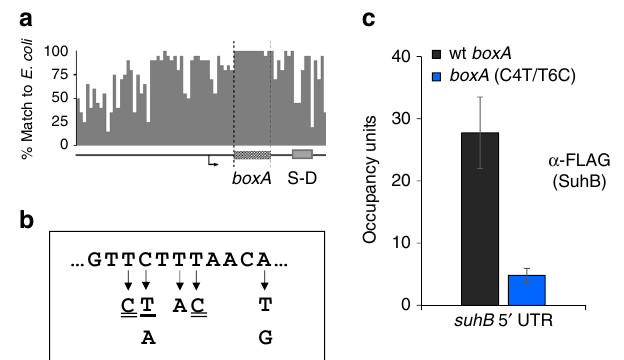
Fig. 2 A functional BoxA in the 5 ′ UTR of suhB . a Sequence conservation of the 100 bp upstream of suhB and its homologues across 20 Enterobacteriaceae species. The transcription start site is indicated by a bent arrow, and the BoxA and S-D sequences are indicated. b List of boxA mutations that are associated with increased suhB expression. All single nucleotide changes are indicated by an arrow. Single underline indicates a mutation that was isolated in the absence of mutations anywhere else in the cloned region; other mutants included additional mutations outside the boxA . Double underline indicates that the boxA mutation was isolated in two or more independent clones. Critical position ‘ − 4 ’ is indicated (see Supplementary Table 2). c SuhB association with the 5 ′ end of suhB in wild- type ( ‘ wt ’ ) and boxA mutant ( ‘ boxA C4T/T6C ’ ) strains. SuhB-FLAG occupancy was measured by ChIP-qPCR using α -FLAG antibody. Error bars represent ± 1 standard deviation from the mean ( n =